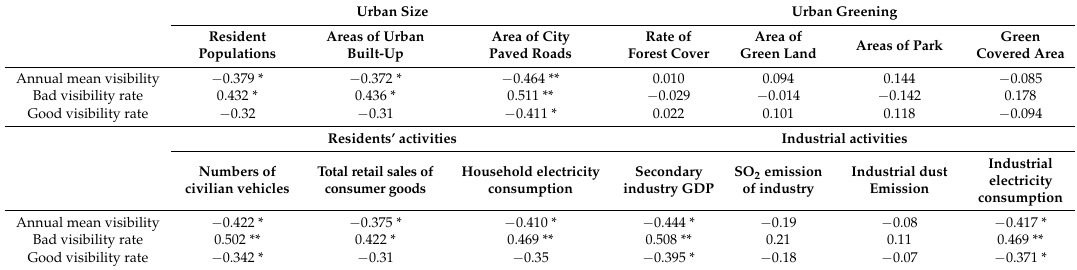
Annualmeanvisibility